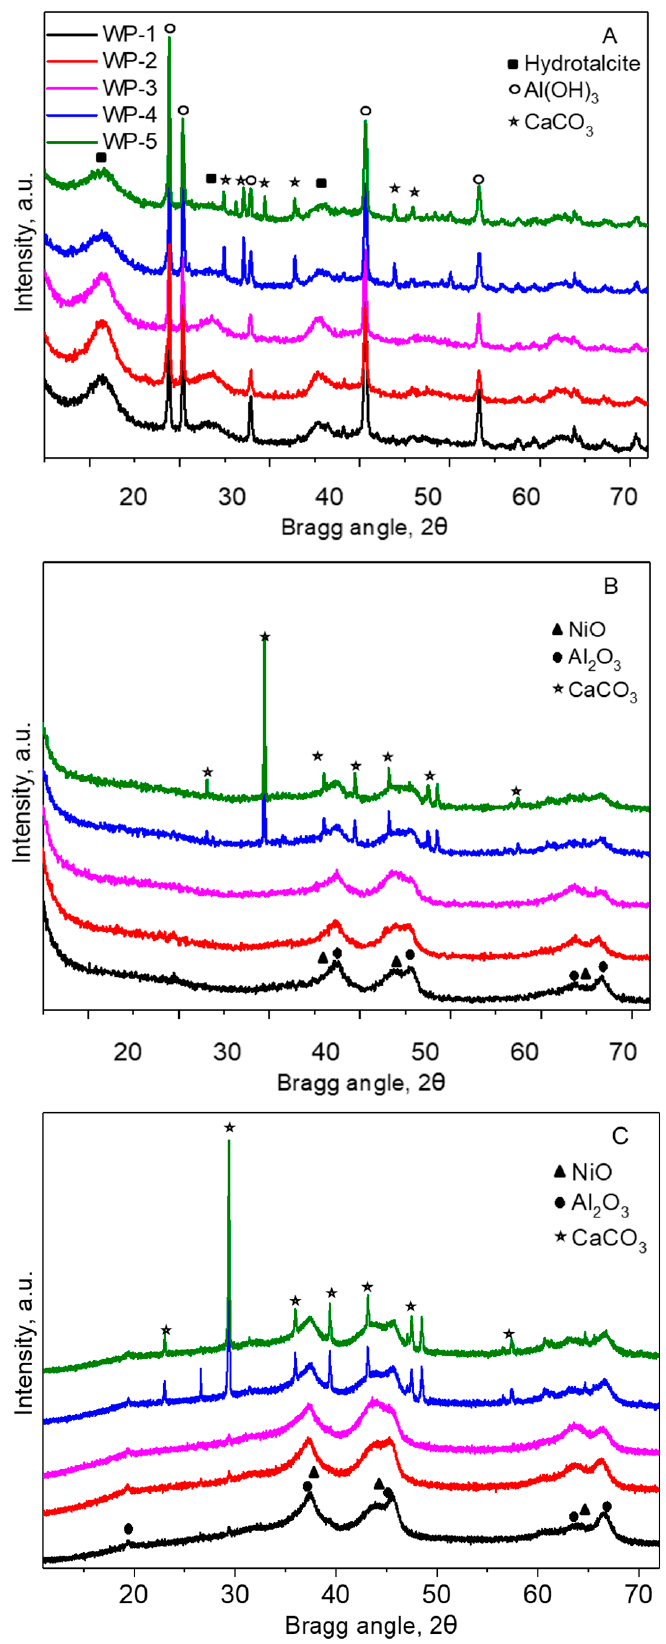
Figure 1. XRD patterns of the ( A ) as prepared, ( B ) calcined, and ( C ) after-reaction samples.